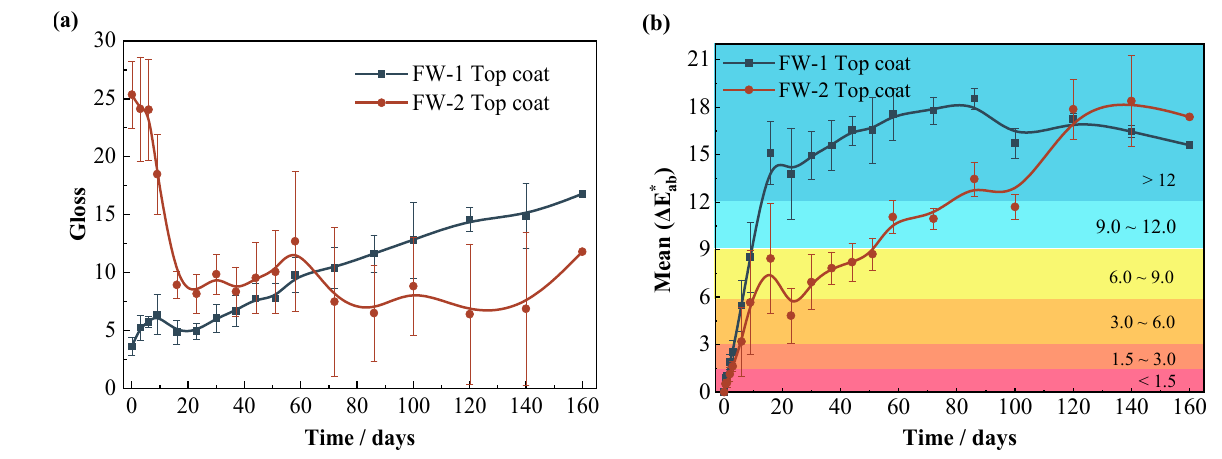
Figure 12. Variations of ( a ) gloss and ( b ) color difference of two coating samples.